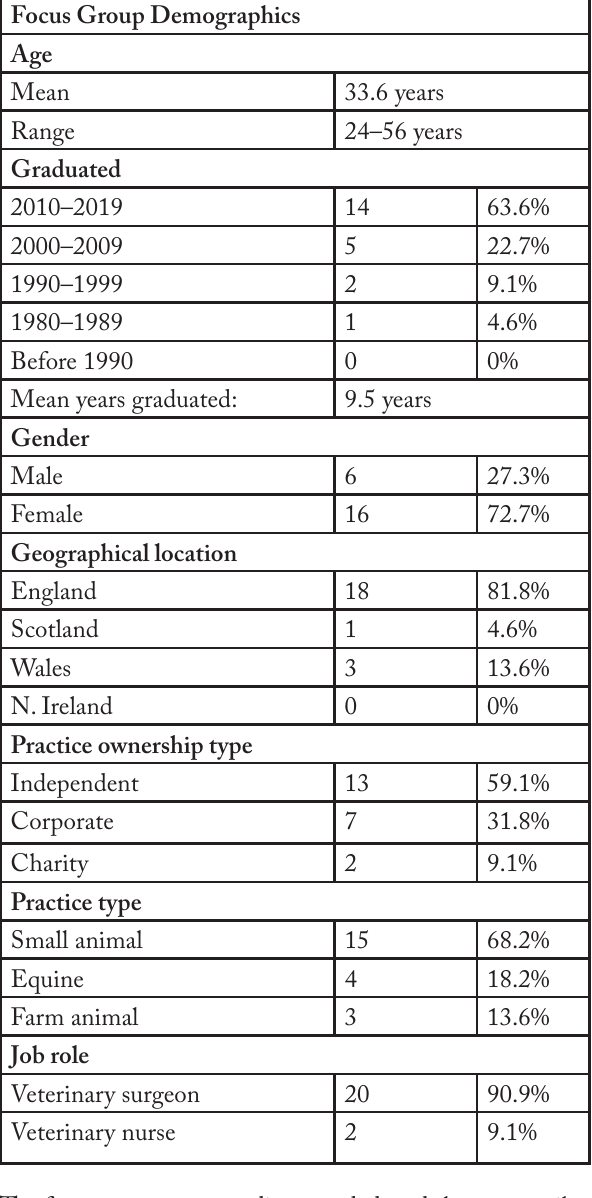
Table 1: Summary information for the focus group participants Focus Group